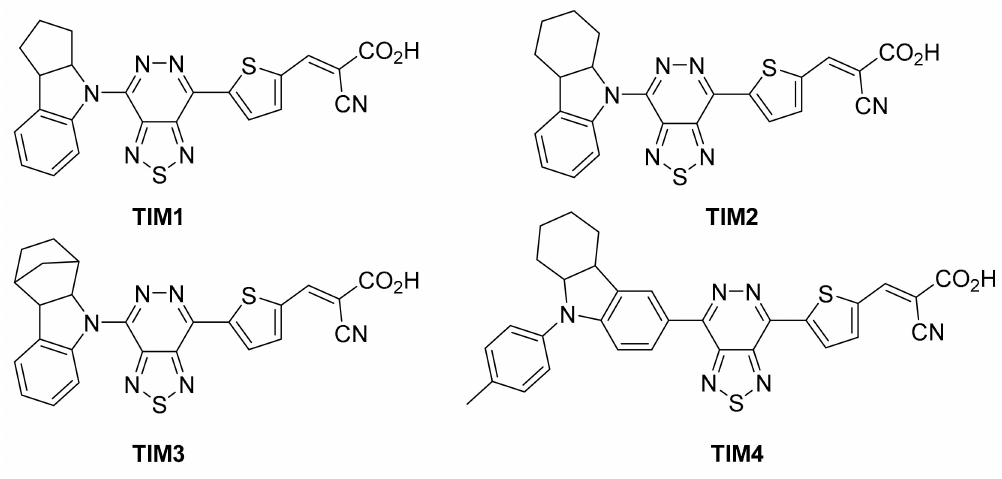
Figure 2. Chemical structures of the dyes